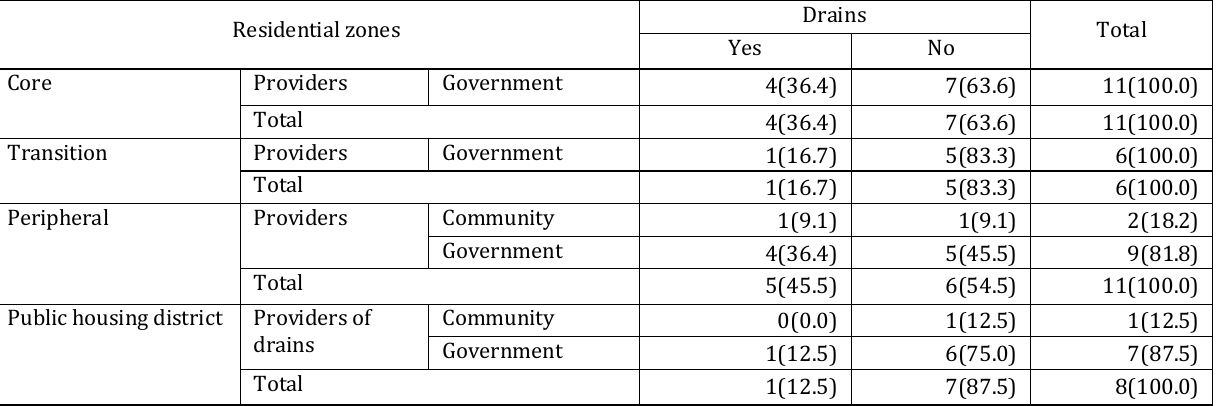
Table 7. Providers of drains across residential zones